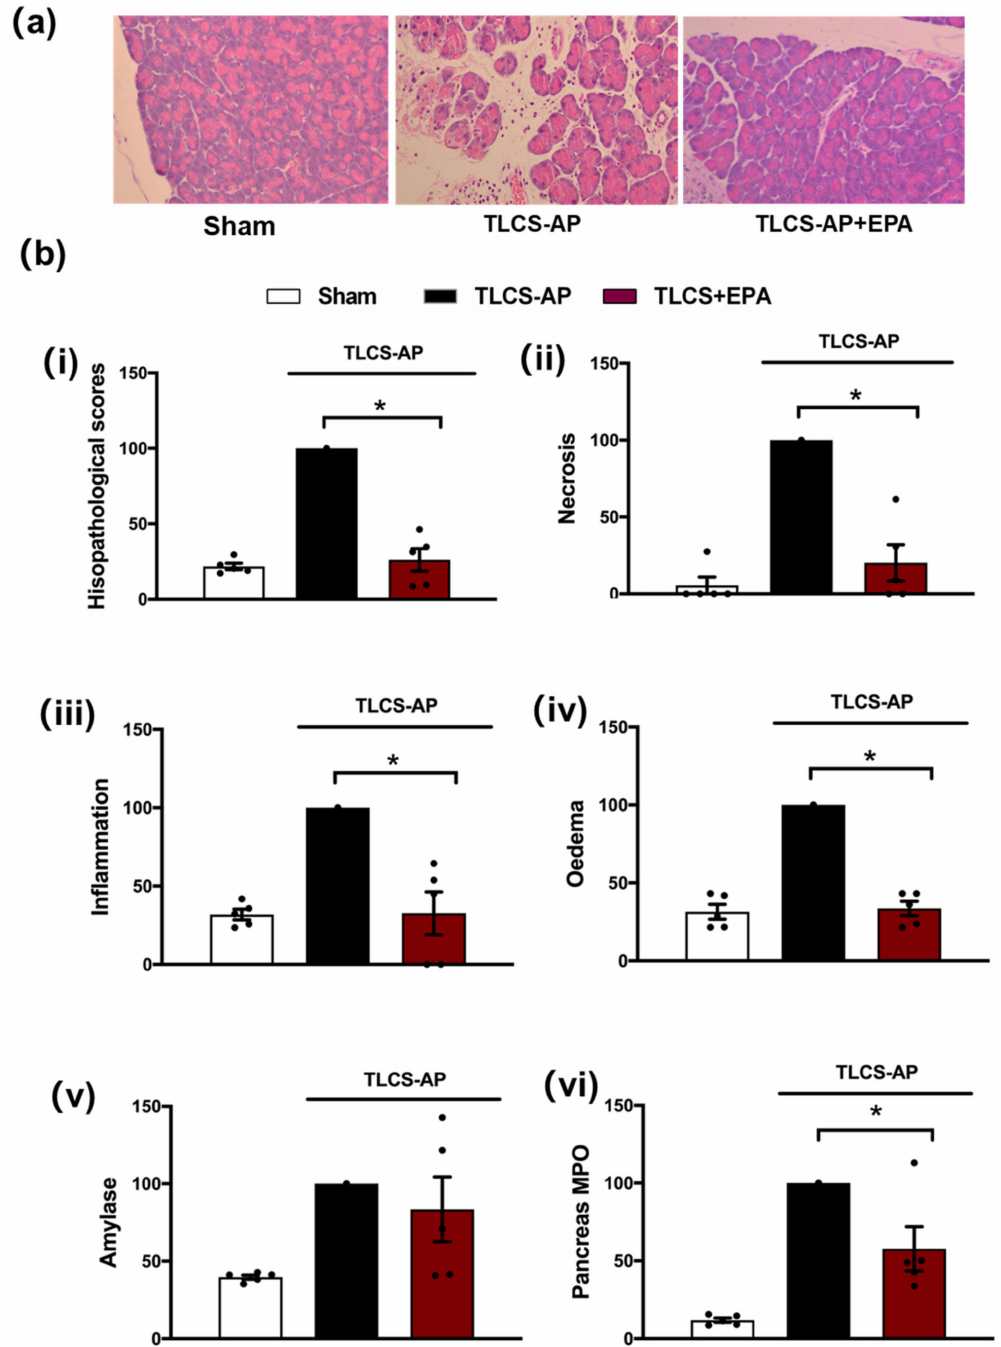
Figure 3. Protective effects of Epacadostat in TLCS-AP. ( a ) Representative H and E pancreas images ( × 200) from sham (control) and TLCS-AP in WT, with and without epacadostat (EPA) treatment. Changes in ( b ) pancreatic histological damage (( i ) total score, ( ii ) necrosis, ( iii ) inflammation and ( iv ) oedema and biochemical alterations of ( v ) amylase and ( vi ) pancreas myeloperoxidase (MPO) in TLCS-AP with and without EPA treatment. Each dot represents a mouse. Responses were normalized to control changes after AP induction in WT and are expressed as the mean ± SEM ( ≥ 5 mice/group). Significant differences between the EPA treatment group and control are shown as * p <